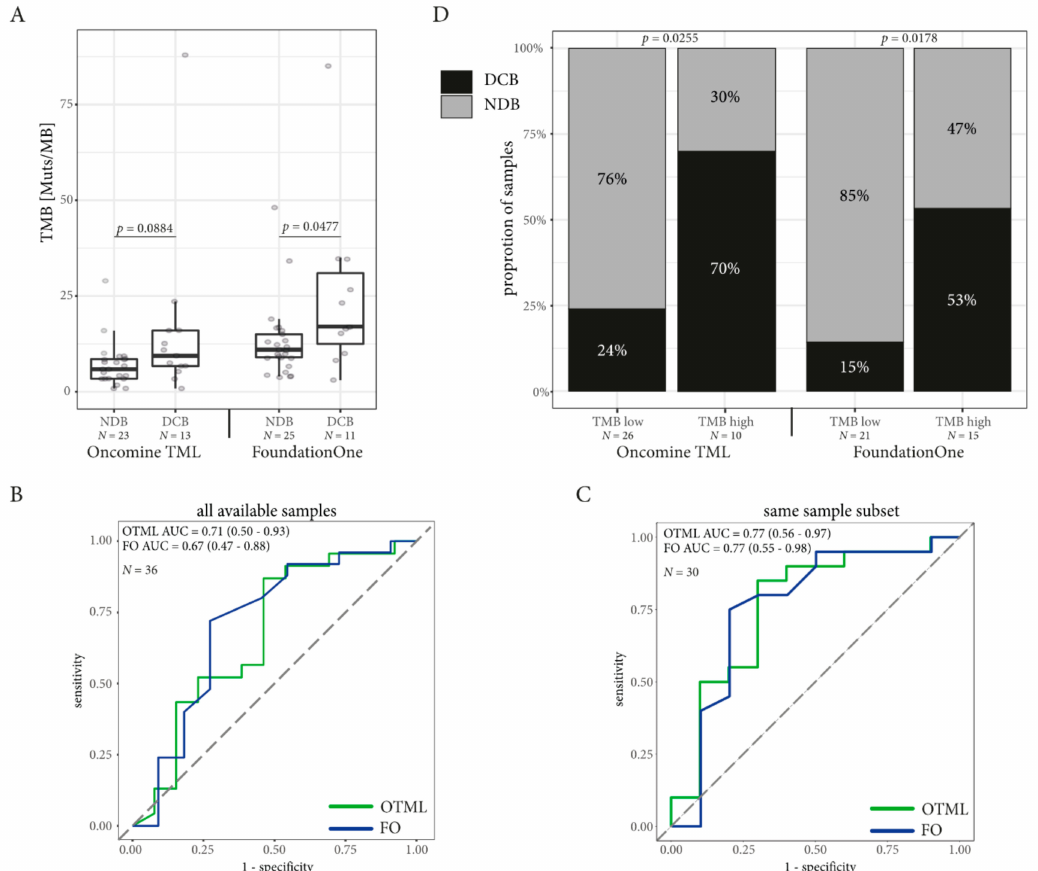
Figure 2. TMB as Biomarker in non-small cell lung cancer. The cut-o ff for high TMB population for the Oncomine TML panel (OTML) is set to 9.39, while the cut-o ff for high TMB population in the FoundationOne test (FO) is set to 15 in the NSCLC population. ( A ) The mean TMB is higher in the DCB cohort than in the NDB cohort. ( B ) The ROC curves with their respective areas under the curve (AUC) are computed on all available data for each test individually. The 95% confidence interval is indicated in brackets. ( C ) The ROC curves with their AUC in the subpopulation where the TMB was correctly assessed using both panels in the same sample cohort allowing direct comparison of the di ff erent TMB panels. The 95% confidence interval is indicated in brackets. ( D ) The ratio of NSCLC patients with a durable clinical benefit (DCB) is greater than the patients with no durable benefit (NDB) in the cohort with high TMB. The number of samples ( N ) used for calculation is mentioned on each